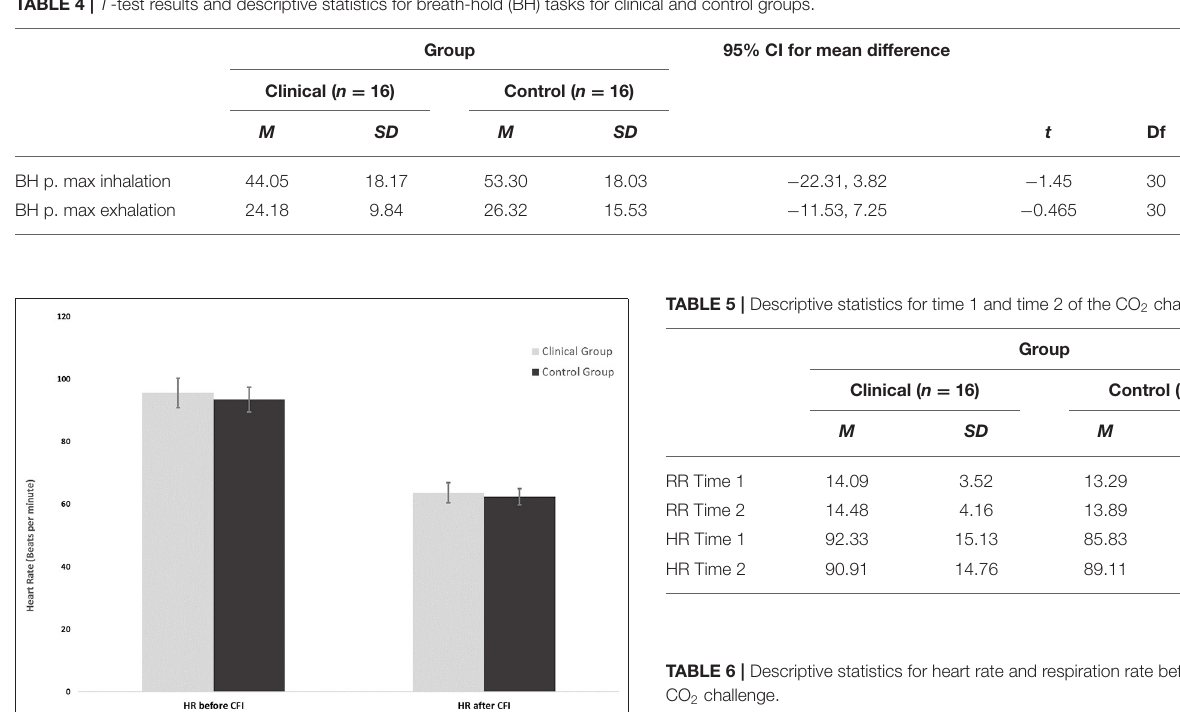
TABLE 4 | T -test results and descriptive statistics for breath-hold (BH) tasks for clinical and control groups.